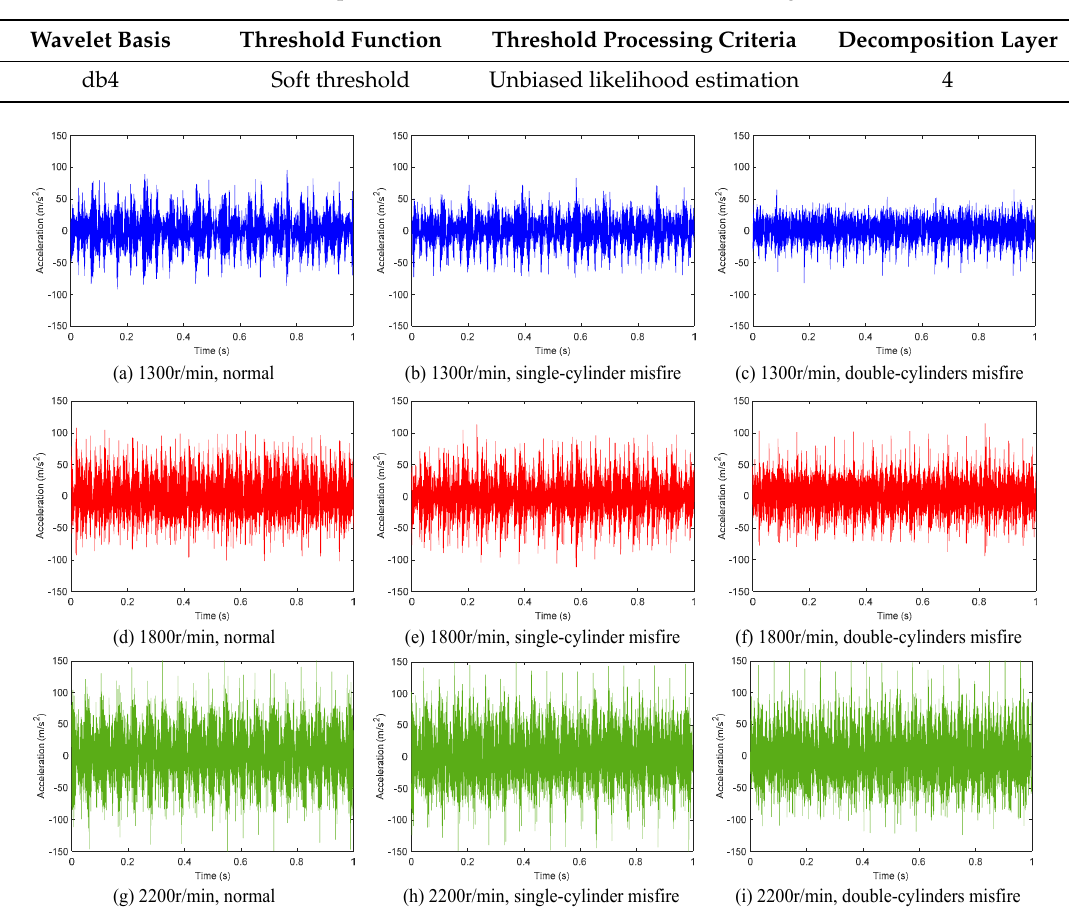
Table 2. Crucial parameters of the wavelet threshold denoising function.